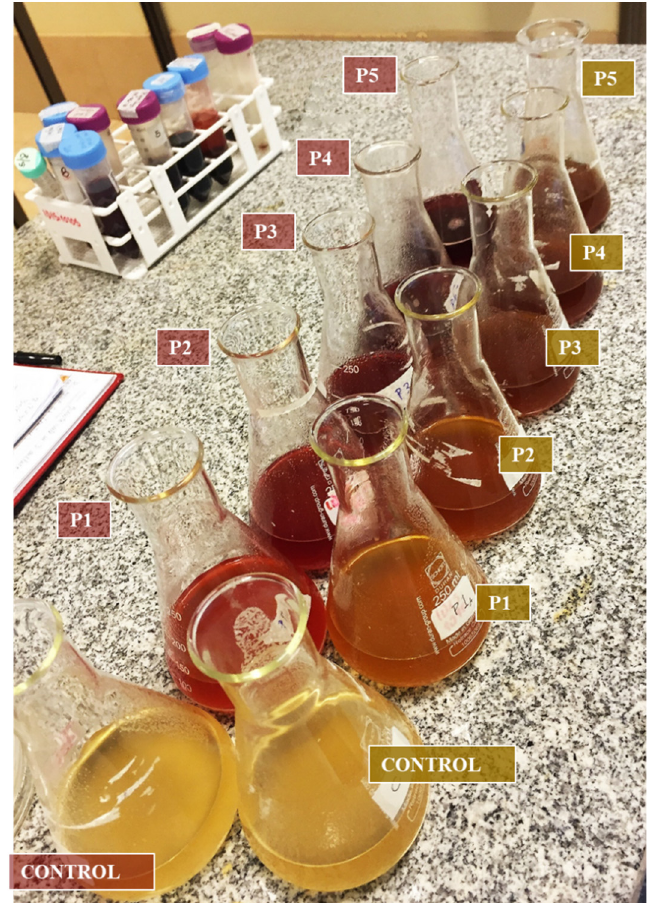
Figure 1. Dilutions of five different concentrations of T. australis (red labels) and P. murcianum (yellow labels). Control = 0 mg/mL, P1 = 1 mg/mL, P2 = 2 mg/mL, P3 = 3 mg/mL, P4 = 4 mg/mL, P5 = 5 mg/mL. Table 1. Treatments with five concentrations of colorants from Penicillium murcianum and Talaromyces australis incorporated in 2%